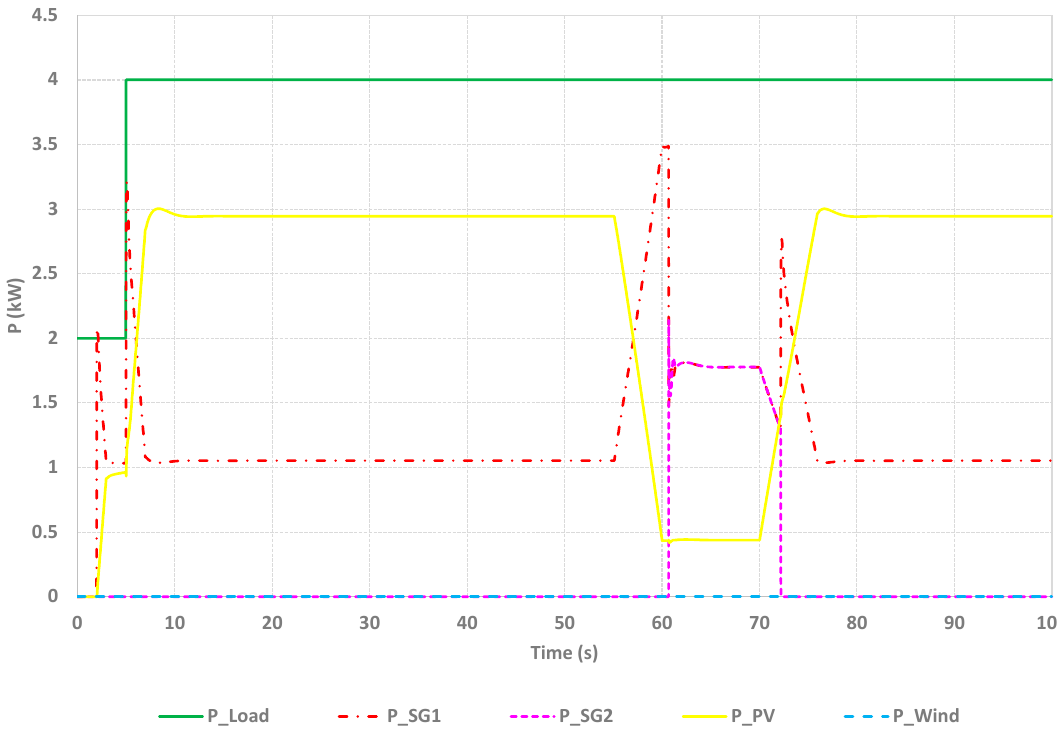
Figure 9. Scenario 4a: Cloud transient analysis for maximum solar PV generation and zero wind generation for a 4 kW demand.